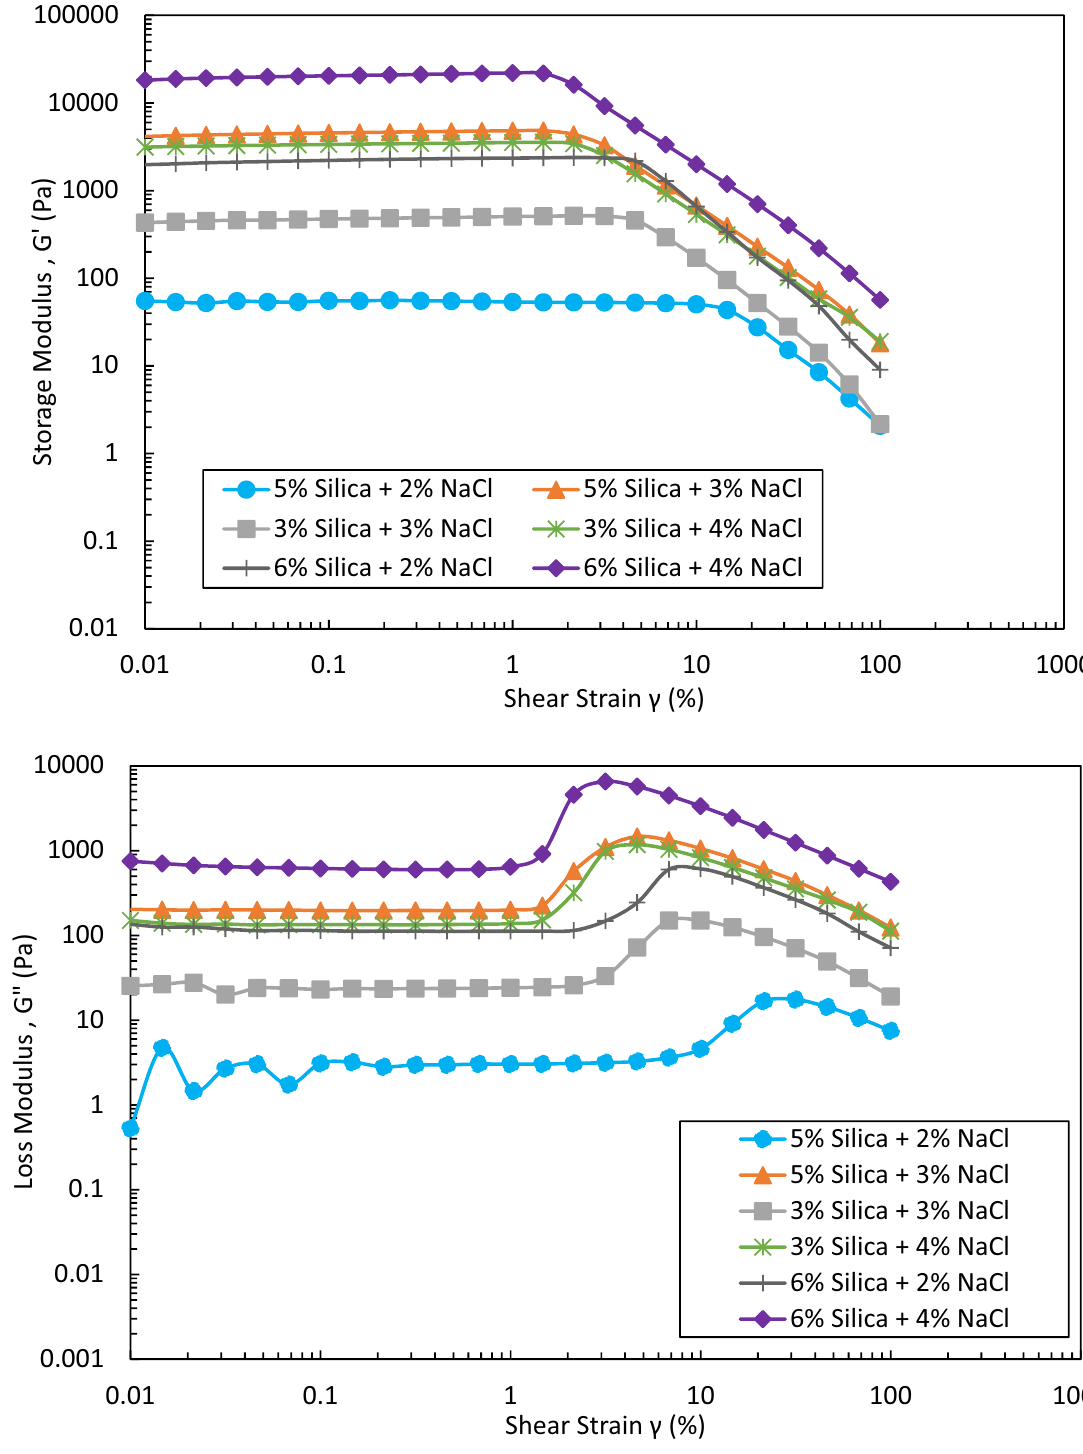
Figure 10. Storage modulus (G ′ ) and loss modulus (G ″ ) versus shear strain for different solid gels formed from different concentrations of silica and NaCl in DIW after 24